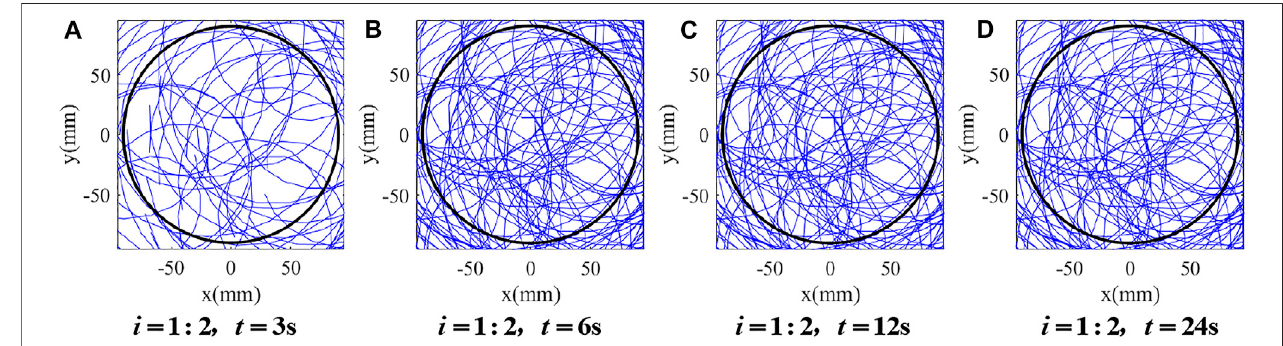
(cid:1)(cid:1) √ (A) i (cid:1) 1 : 2